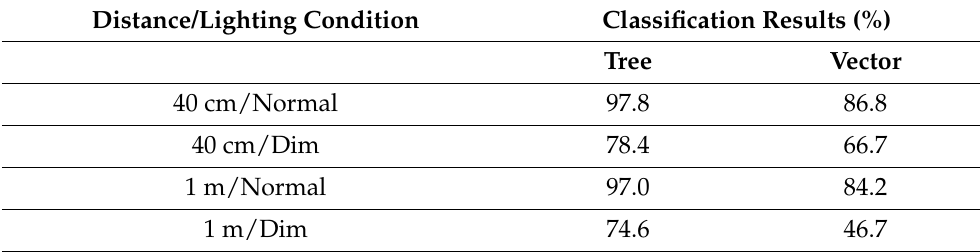
Table 2. Classification results for four environmental conditions.